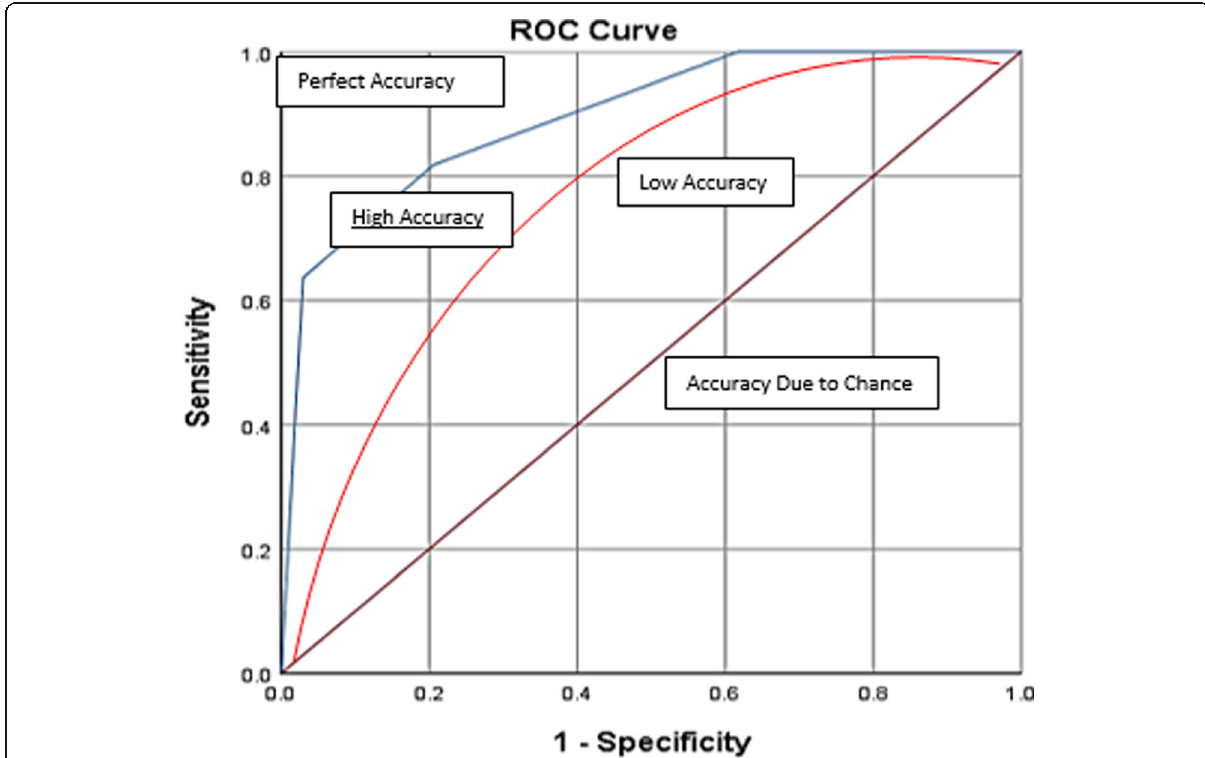
Fig. 3 AUC of ROC for decision tree evaluation (change from CPAP to